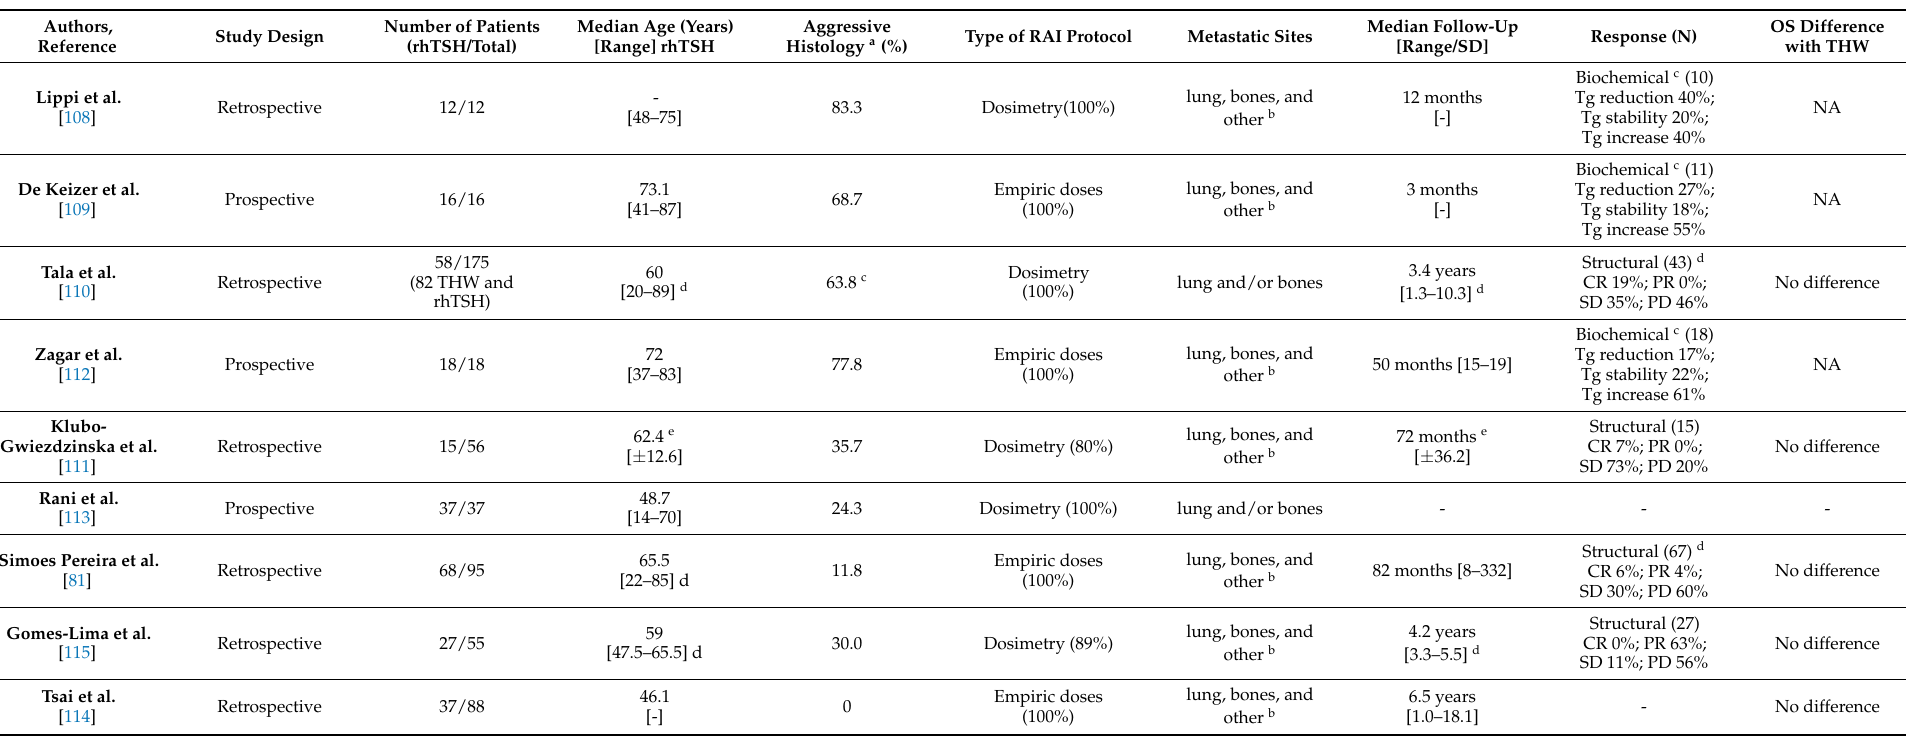
Table 4. Overview of studies exploring rhTSH preparation for therapeutic radioiodine treatment in patients with distant